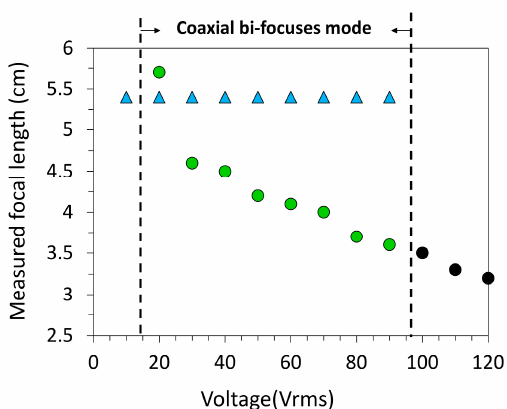
Figure 10. The measurements of the electrically tunable focal lengths in the TLCL lens with switching coaxial bi-focus and single focus modes; the blue solid triangles denote the fixed focal length from the LCs in the LCL-2 layer; the green solid circles denote the electrically tunable focal lengths from the LCs in the LCL-1 layer; and the black solid circles denote the electrically tunable focal lengths in single focus mode at higher voltages.